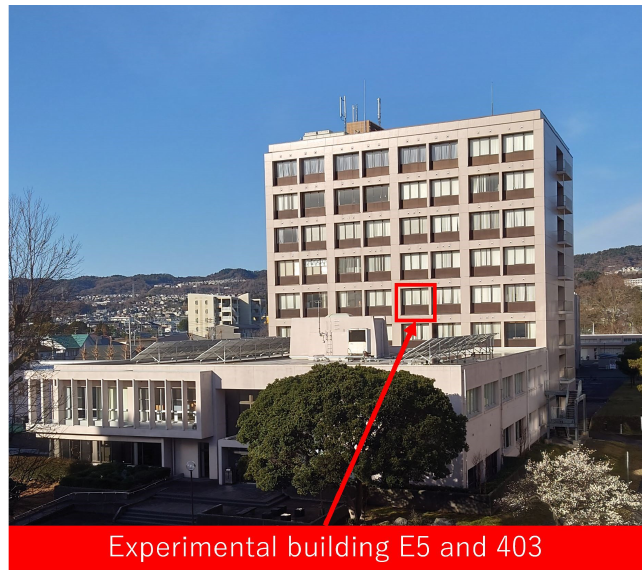
Figure 7. Experimental